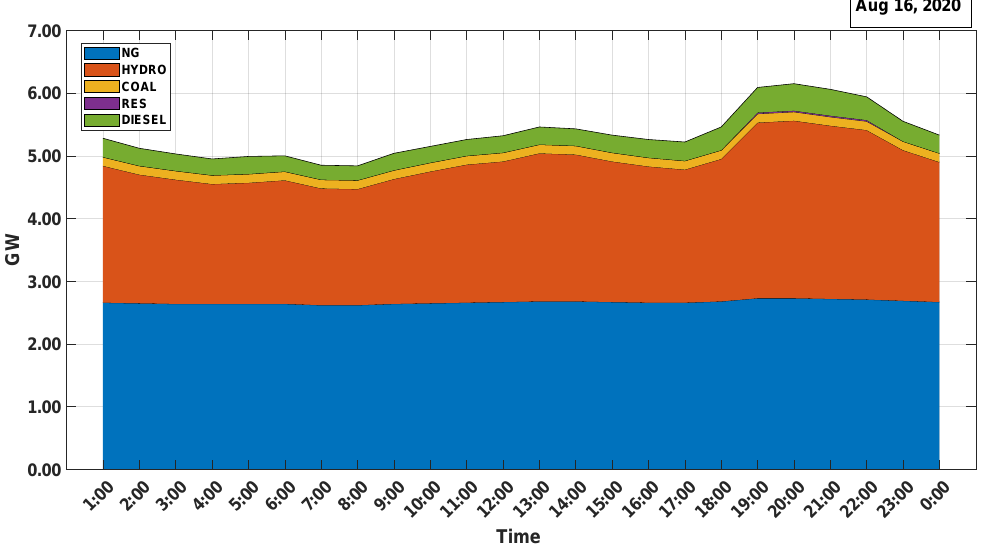
Figure 14. Contribution to the dispatch of the electrical system—stage